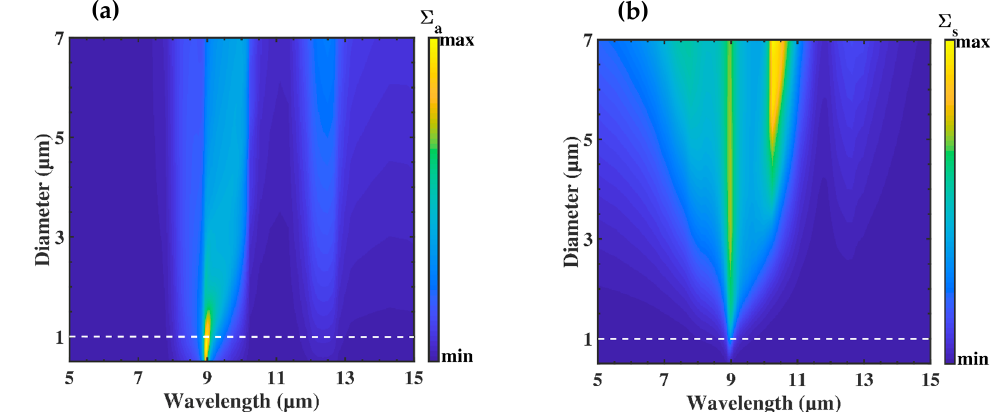
Figure 2. Normalized ( a ) absorption cross-section σ a and ( b ) scattering cross-section σ s of a single SiO 2 particle in PE medium over the wavelength range 5–15 µ m as a function of the diameter D of the particle, varied from 0.5 to 7 µm.